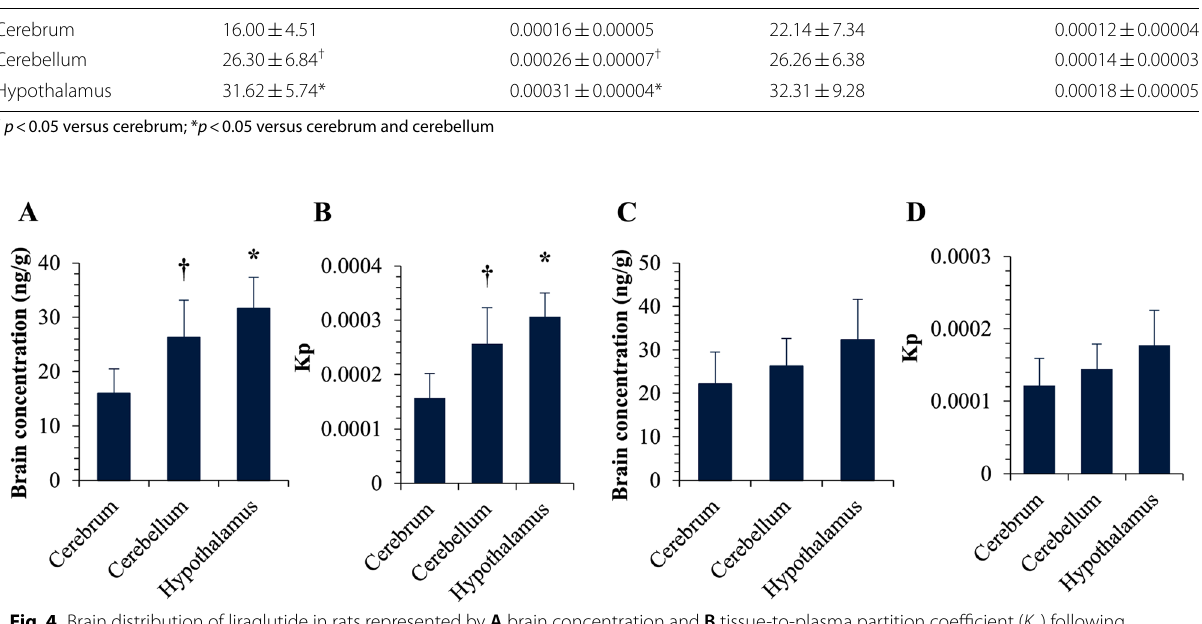
SD, n 6). † p < 0.05 versus ± =